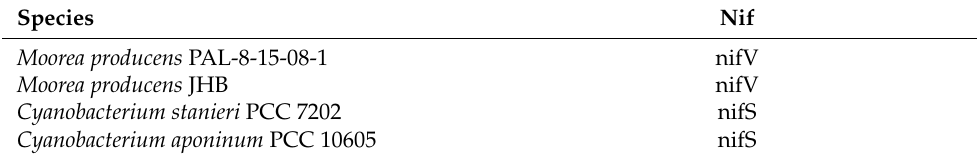
Table 1. Non-diazotrophic Cyanobacteria with homologs to nifs coded by nif operons of diazotrophs. Species Nif Moorea producens PAL-8-15-08-1 nifV Moorea producens JHB nifV Cyanobacterium stanieri PCC 7202 nifS Cyanobacterium aponinum PCC